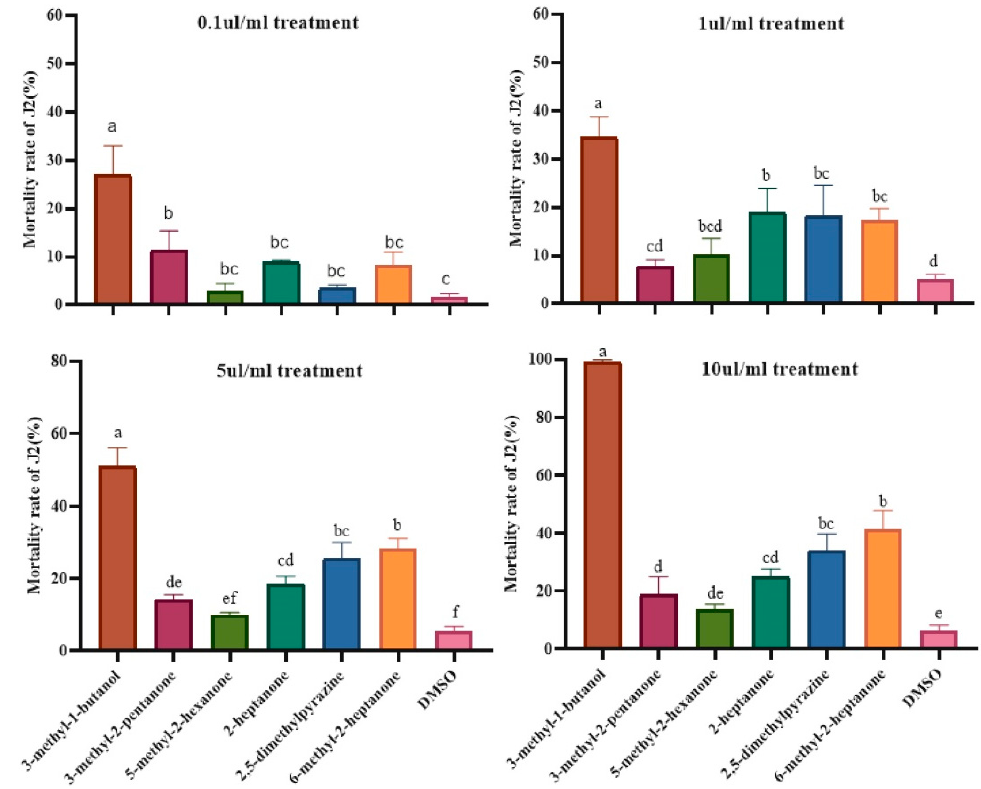
Figure 4. Fumigant effects of six VOCs on second stage juveniles at different concentrations. Different lowercase letters indicate significant differences among treatments ( p < 0.05); bars indicate the standard error of the means ( n = 3).